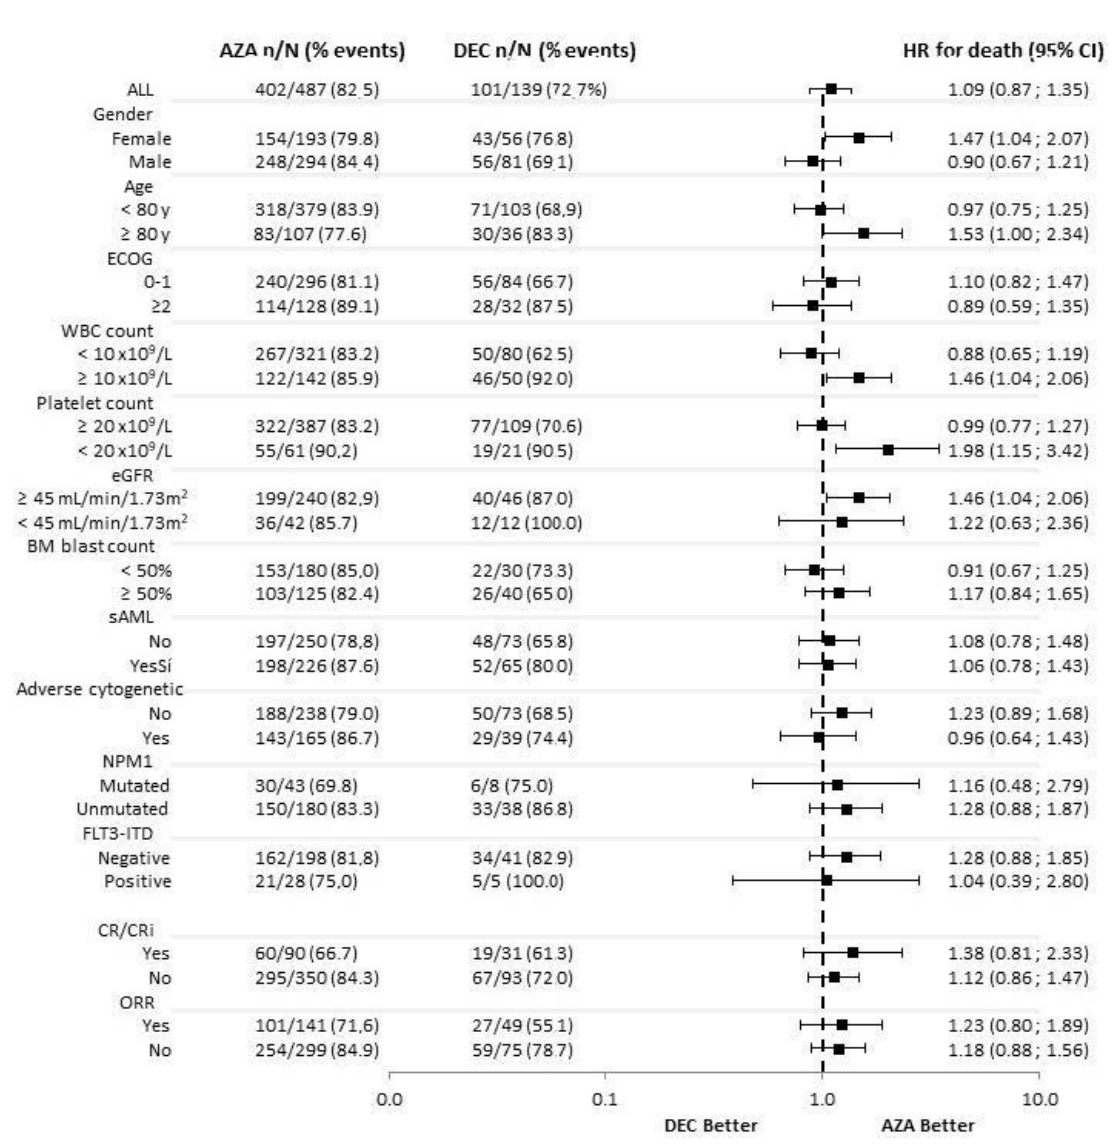
Figure 5. Subgroup Analysis of Overall Survival. AML, Acute myeloid leukemia; AZA, azacitidine; BM, bone marrow; CR, complete remission; CRi, complete remission with incomplete blood count recovery; DEC, decitabine; ECOG, Eastern Cooperative Oncology Group; eGFR, estimated glomerular filtrate rate; FLT3, FMS-like tyrosine kinase 3; ITD: internal tandem duplication; NPM1, Nucleophos- min1; ORR, overall response rate (CR + CRi + PR); PR, partial remission; sAML, secondary AML; WBC, white blood